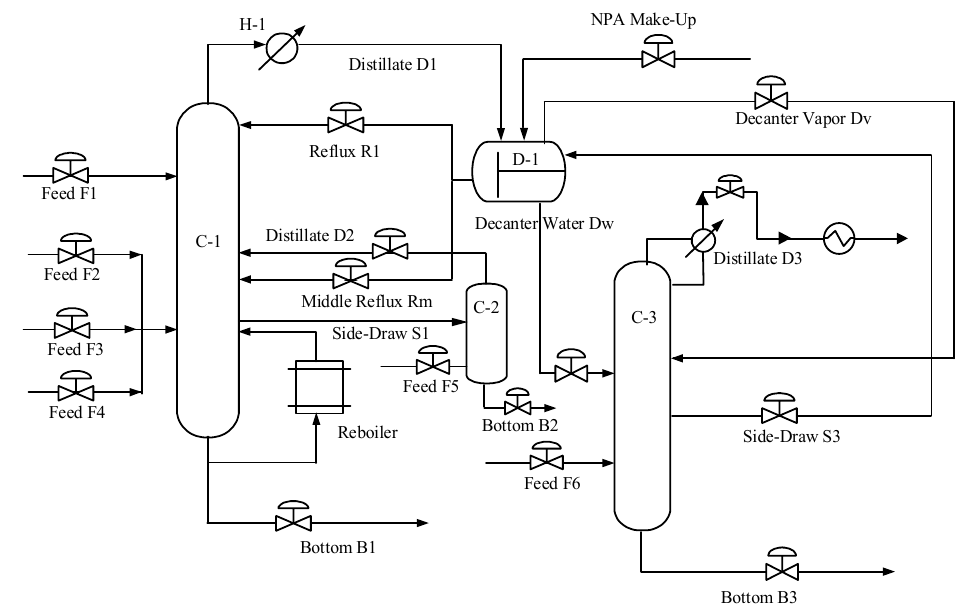
Figure 1. Acetate dehydration steady-state process flow.